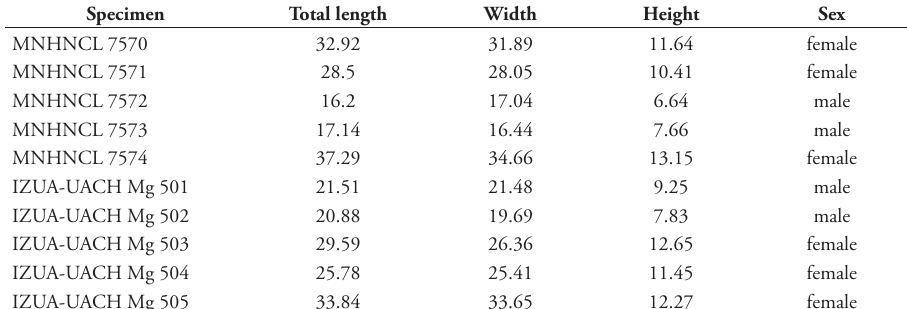
Table 1. Shell morphometrics of Calyptraea aurita . All measurements in mm.